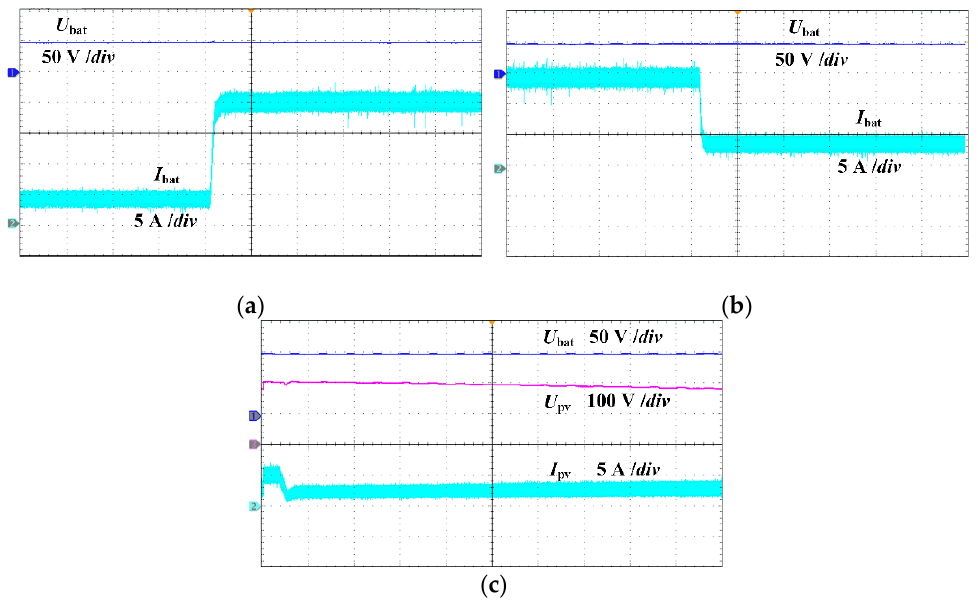
Figure 20. Waveforms in Battery/PV test system: ( a ) battery output current increases with the increase of load; ( b ) battery output current declines with the decrease of load; ( c ) regulating process when illumination intensity decreases.